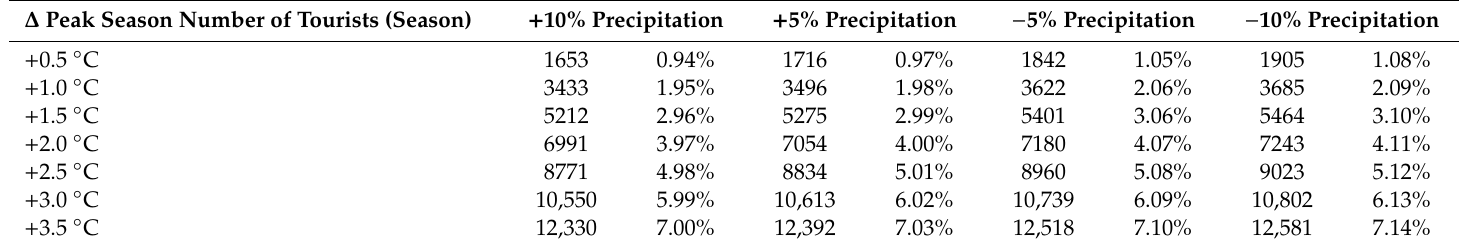
Table 6. Peak season number of tourists increase (persons per season) and increate rate